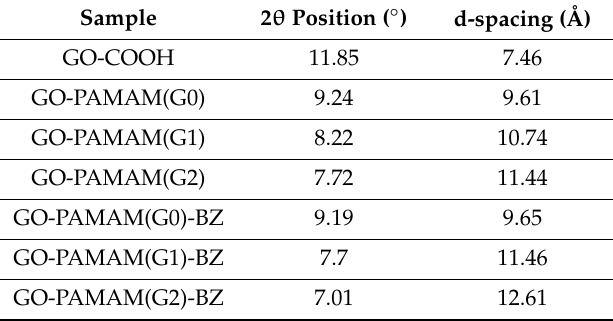
Figure10. XRDcurvesfortheinvestigatedmaterials: ( a )GO-PAMAM(G0)-BZ,( b )GO-PAMAM(G1)-BZ, Figure 10. XRD curves for the investigated materials: ( a ) GO-PAMAM(G0)-BZ, ( b ) ( c ) GO-PAMAM(G2)-BZ. Table 3. Structural parameters obtained from XRD Table 3. Structural parameters obtained from XRD patterns.